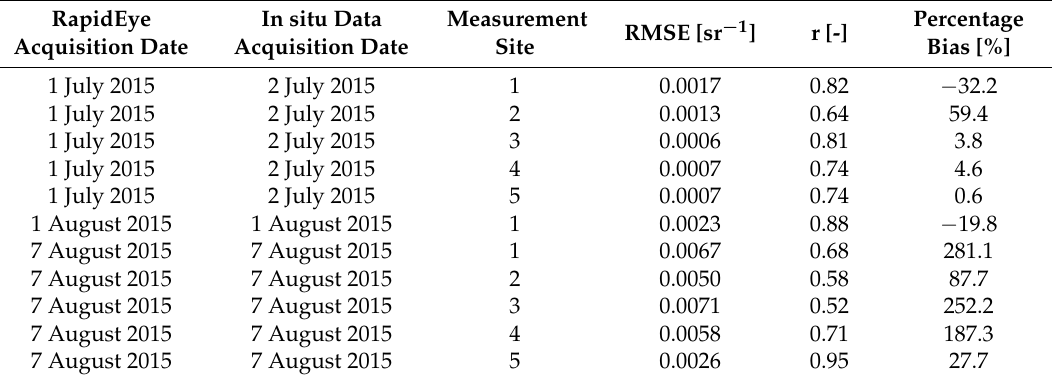
( λ ) median spectra (bands 1–4). rs